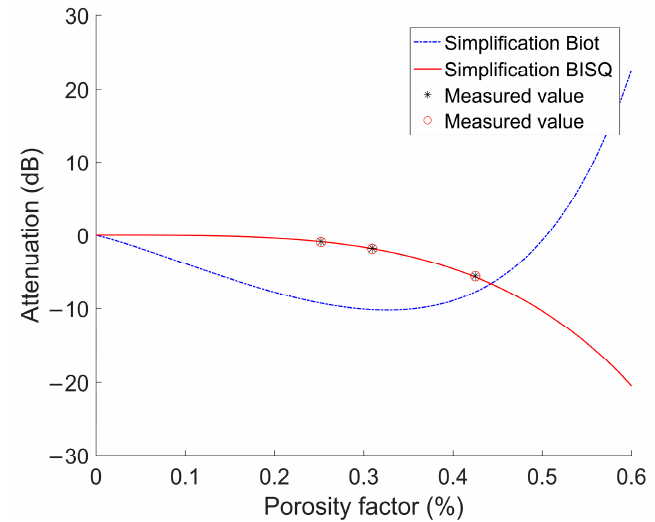
Figure 6. CRC sound velocity.